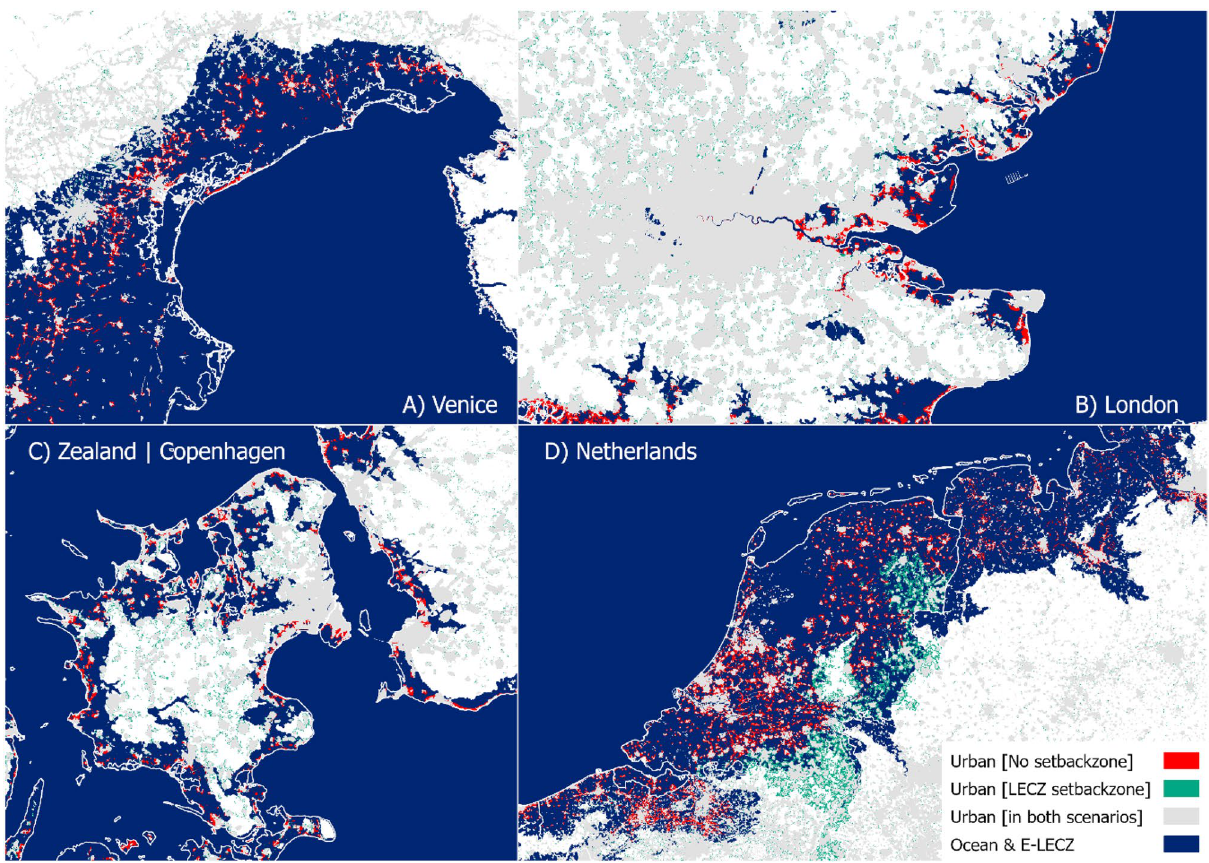
Figure 5. Comparison of the spatial allocation of new urban fabric under a 10 m elevation setback (called LECZ setback) and No setback in 2100 [high urban growth scenario].